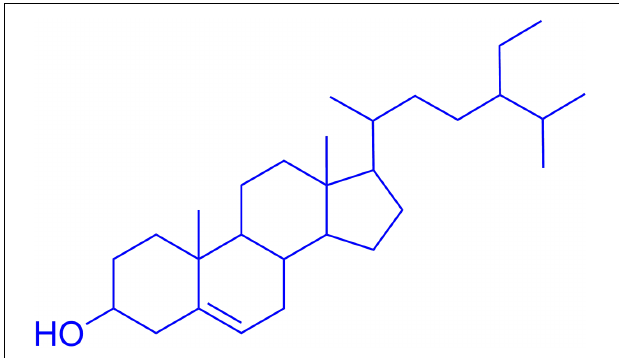
FIGURE 1 | Chemical structure of β -sitosterol.